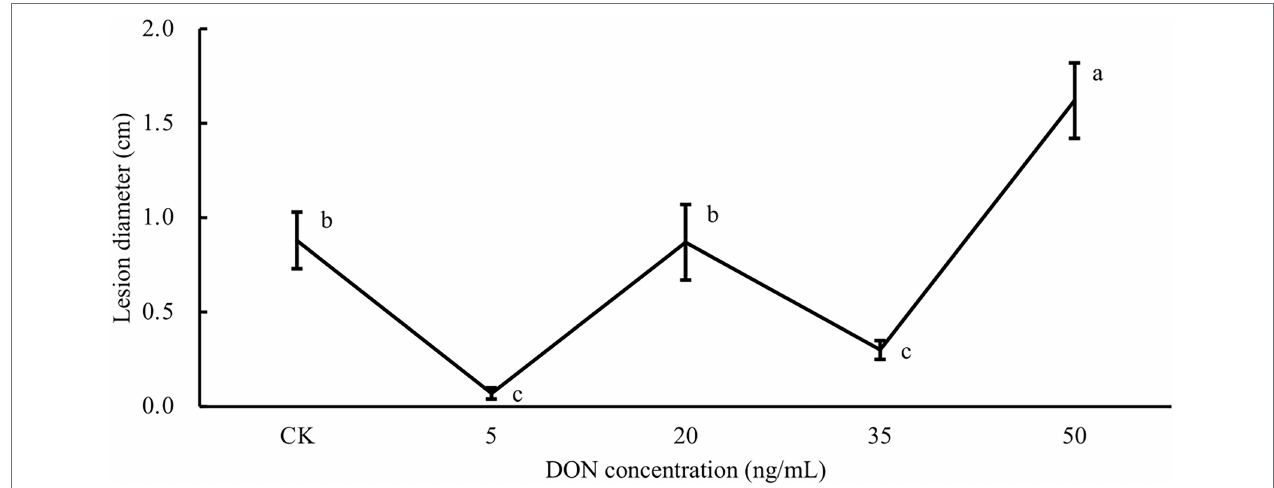
FIGURE 5 | Potatoes treated with different DON concentrations were inoculated with Fusarium sambucinum . Comparative analysis of potato tuber lesion diameters after different DON concentration